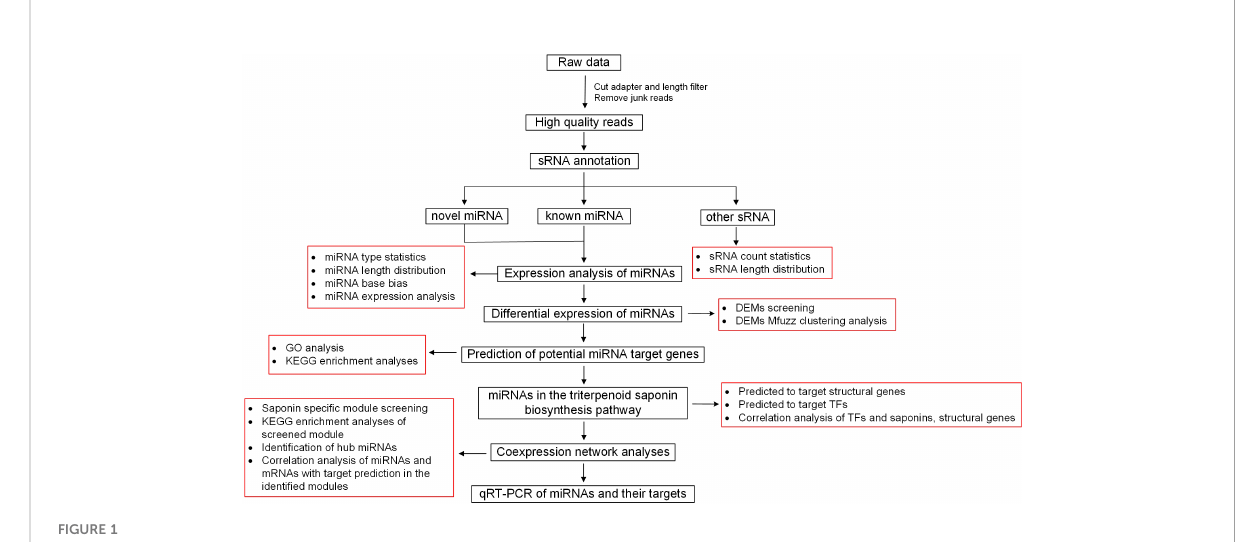
FIGURE 1 Methodology procedure